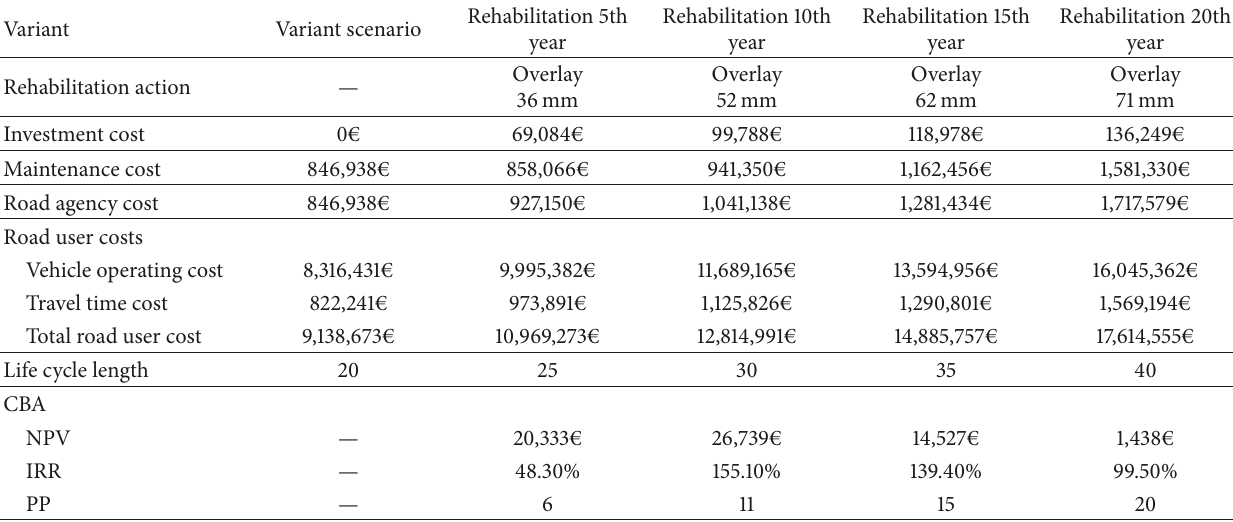
Table 7: Life cycle cost analysis and cost benefit analysis.